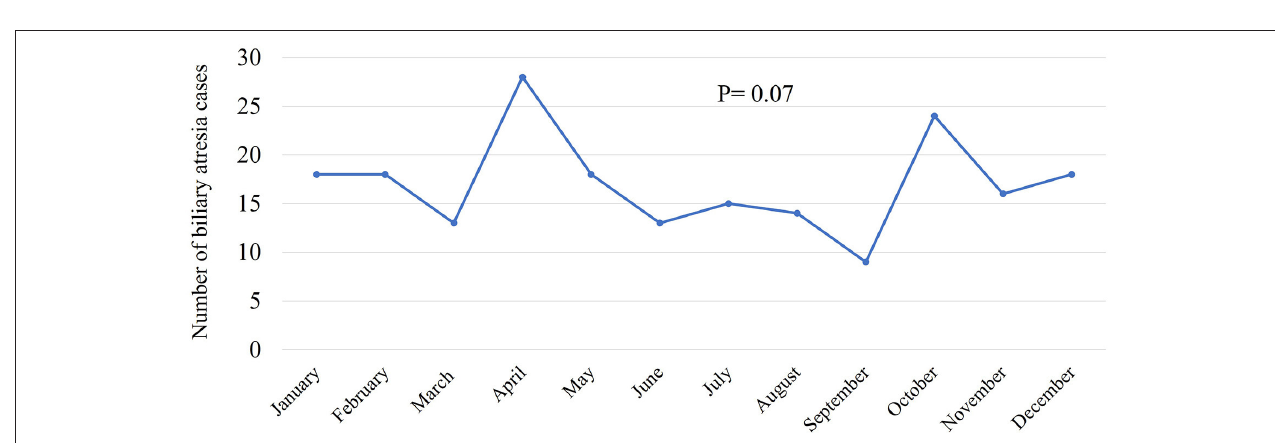
FIGURE 1 | Incidence of biliary atresia cases per 100,000 live births per year.